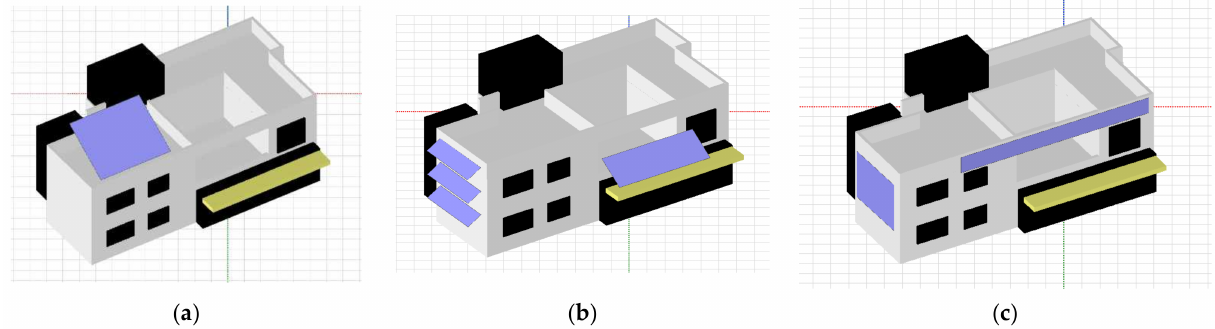
Figure 3. Residential PVSCS PVSYST models ( a ) Original layout ( b ) Design using canopies ( c ) Design using modules attached to the